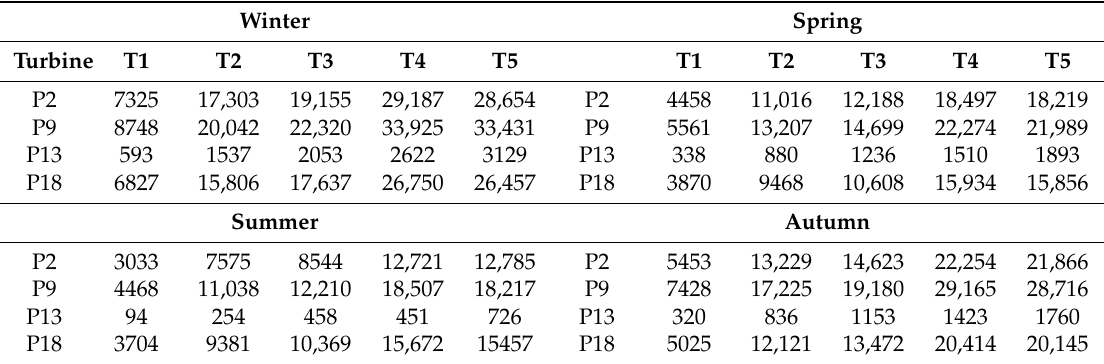
Table 4. The AEP production (MWh) corresponding to the offshore wind turbines on a seasonal level. Results available for the interval from January 1998 to December 2017 (ERA-Interim wind